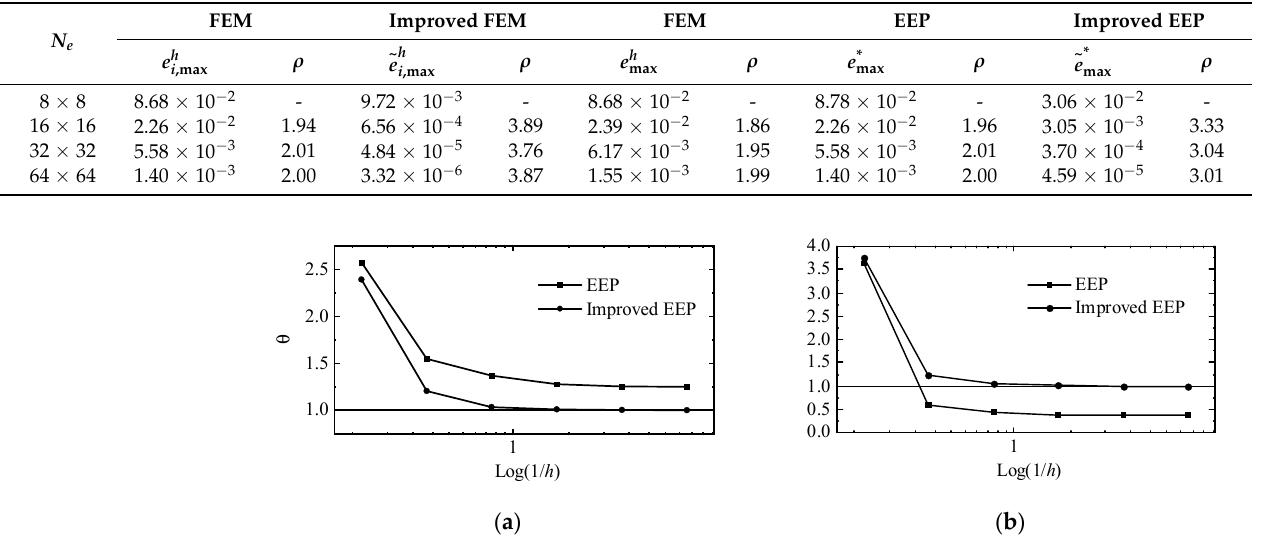
Figure 8. Distributions of effective index: ( a ) component in the x direction; ( b ) component in the y direction.